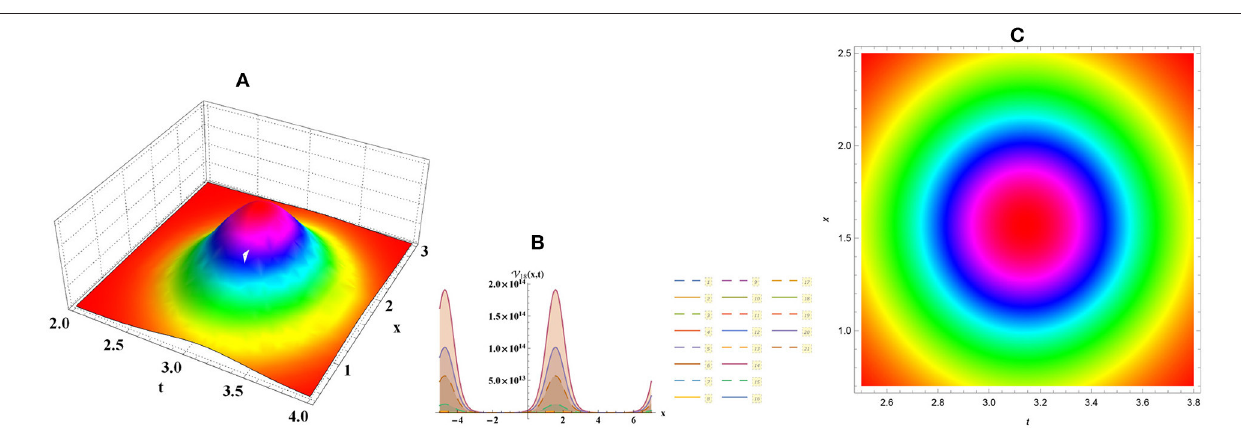
FIGURE 7 | Bright cone numerical graph for Equation (24) through (A) three-dimensional, (B) two-dimensional, and (C) density plots.